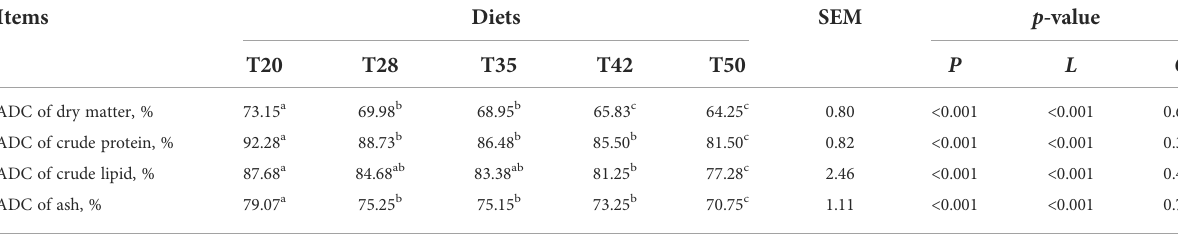
TABLE 4 Apparent digestibility coef fi cients (ADCs) of nutrients by L. vannamei fed with experimental diets.